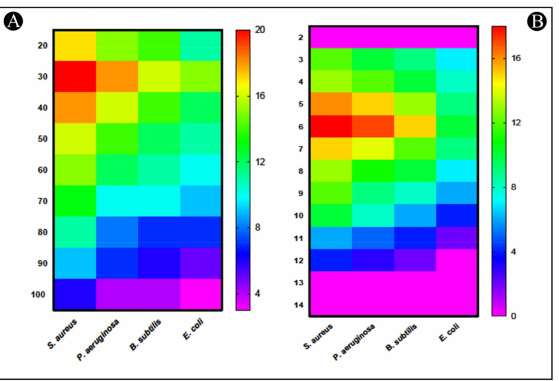
Figure 2. Effect of ( A ) temperature, and ( B ) pH on the activity of Bac10307 extracted from L. acidophilus .